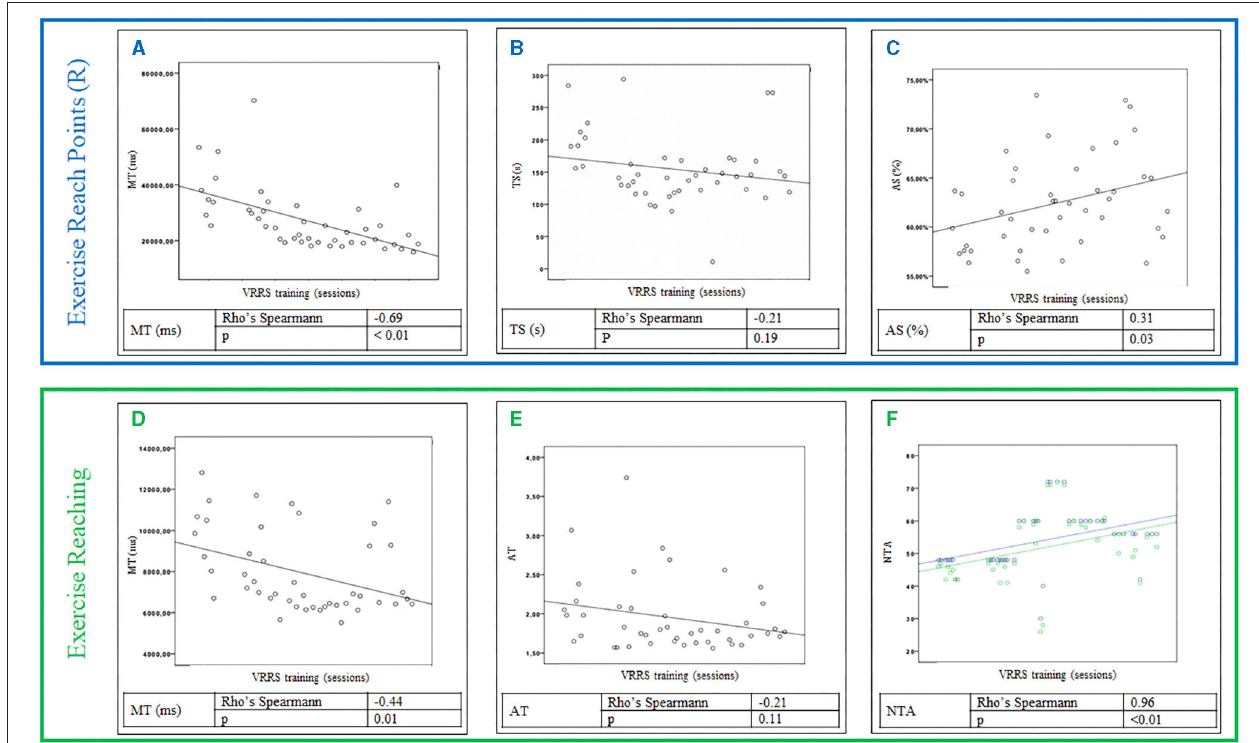
FIGURE 3 | Upper section, Reach points (R) exercise results: values of the Mean Time (MT) to reach the target (A) , the Time Spent (TS) (B) and the Average Score (AS) (C) obtained in relation to the session performed during the VRRS training. Lower section, Reaching exercise: Values of the Mean Time (MT) to reach the target (D) , the Average Ratio (AT) between the distance covered and the minimum distance to be covered (E) , both in relation to the session performed, and the Number of Targets Achieved (NTA) (in green) and those to be achieved (blue) (F) during the VRRS